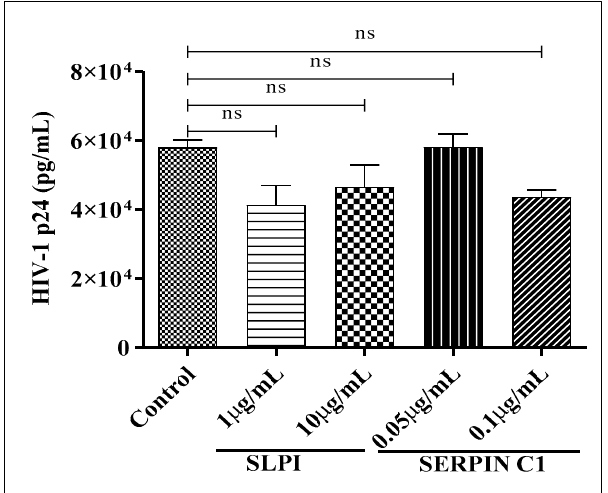
Figure 5. Impact of SLPI and SERPIN C1 on HIV-1 replication post integration. U1 cells (5 × 10 5 cells/well) were pre-treated with SLPI (1 μ g/mL and 10 μ g/mL) or SERPIN C1 (0.05 μ g/mL and 0.1 μ g/mL) for 2 h followed by activation by PMA (20 ng/mL) for 48 h. Culture supernatants were collected and HIV-1 p24 antigen was quantitated by ELISA. Results expressed as mean ± SEM from three independent experiments. Mark (ns) over the bars indicates the non-significant difference with control, ns p > 0.05. p -values were generated by one-way ANOVA with multiple comparisons.